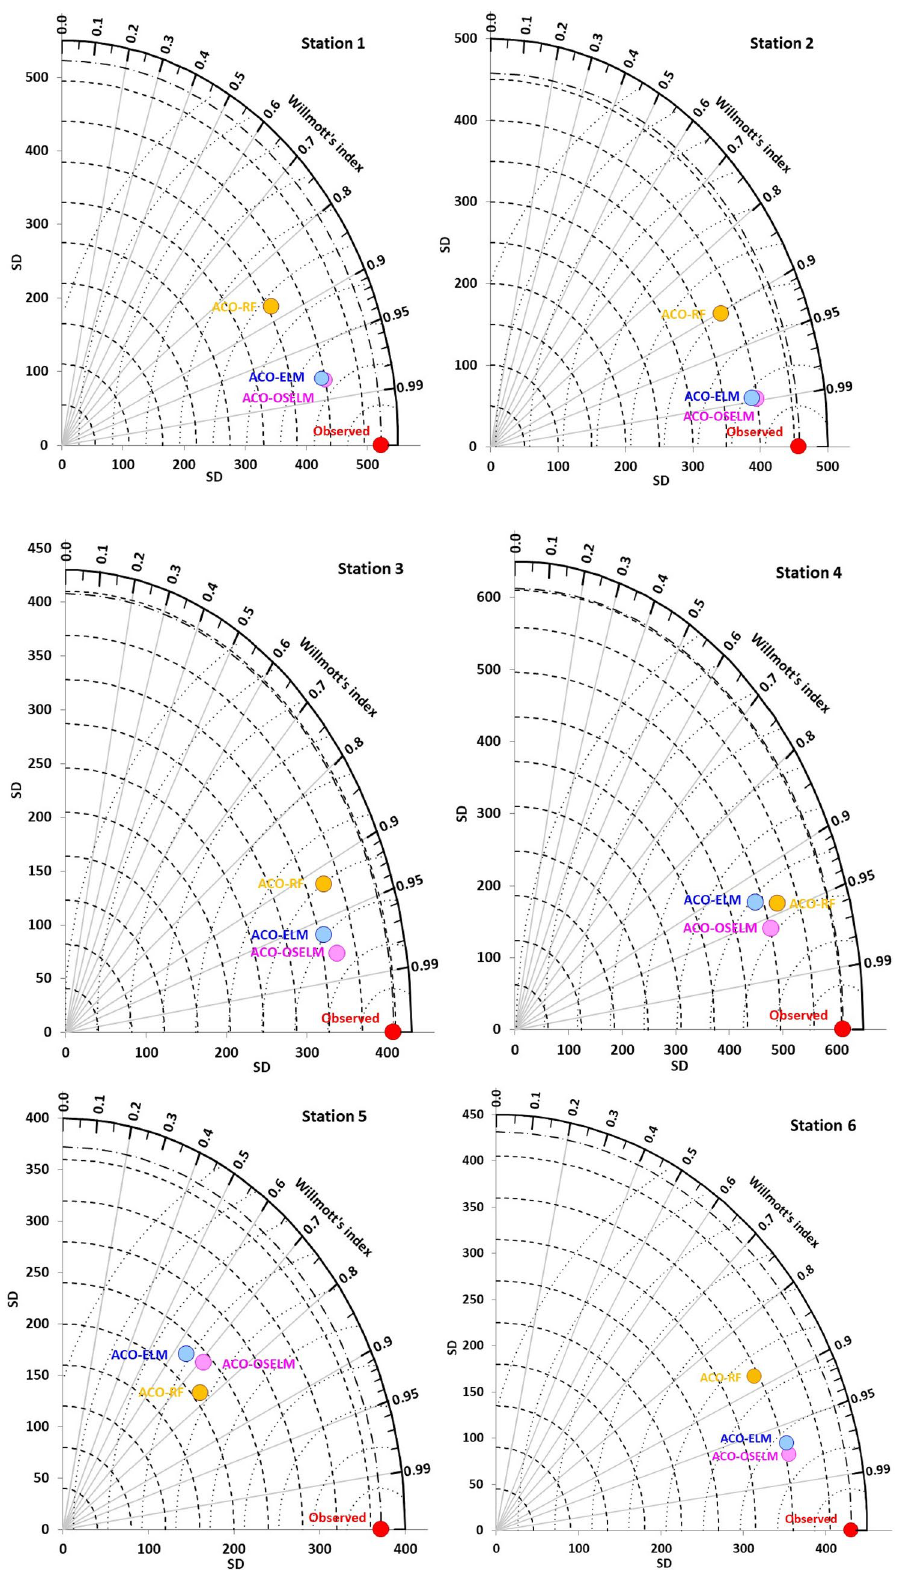
Figure 9. Vector field evaluation (VFE) diagram showing Willmott’s agreement between the observed and predicted wheat yield and standard deviation (SD) of ACO-OSELM versus ACO-ELM and ACO-RF models for all tested